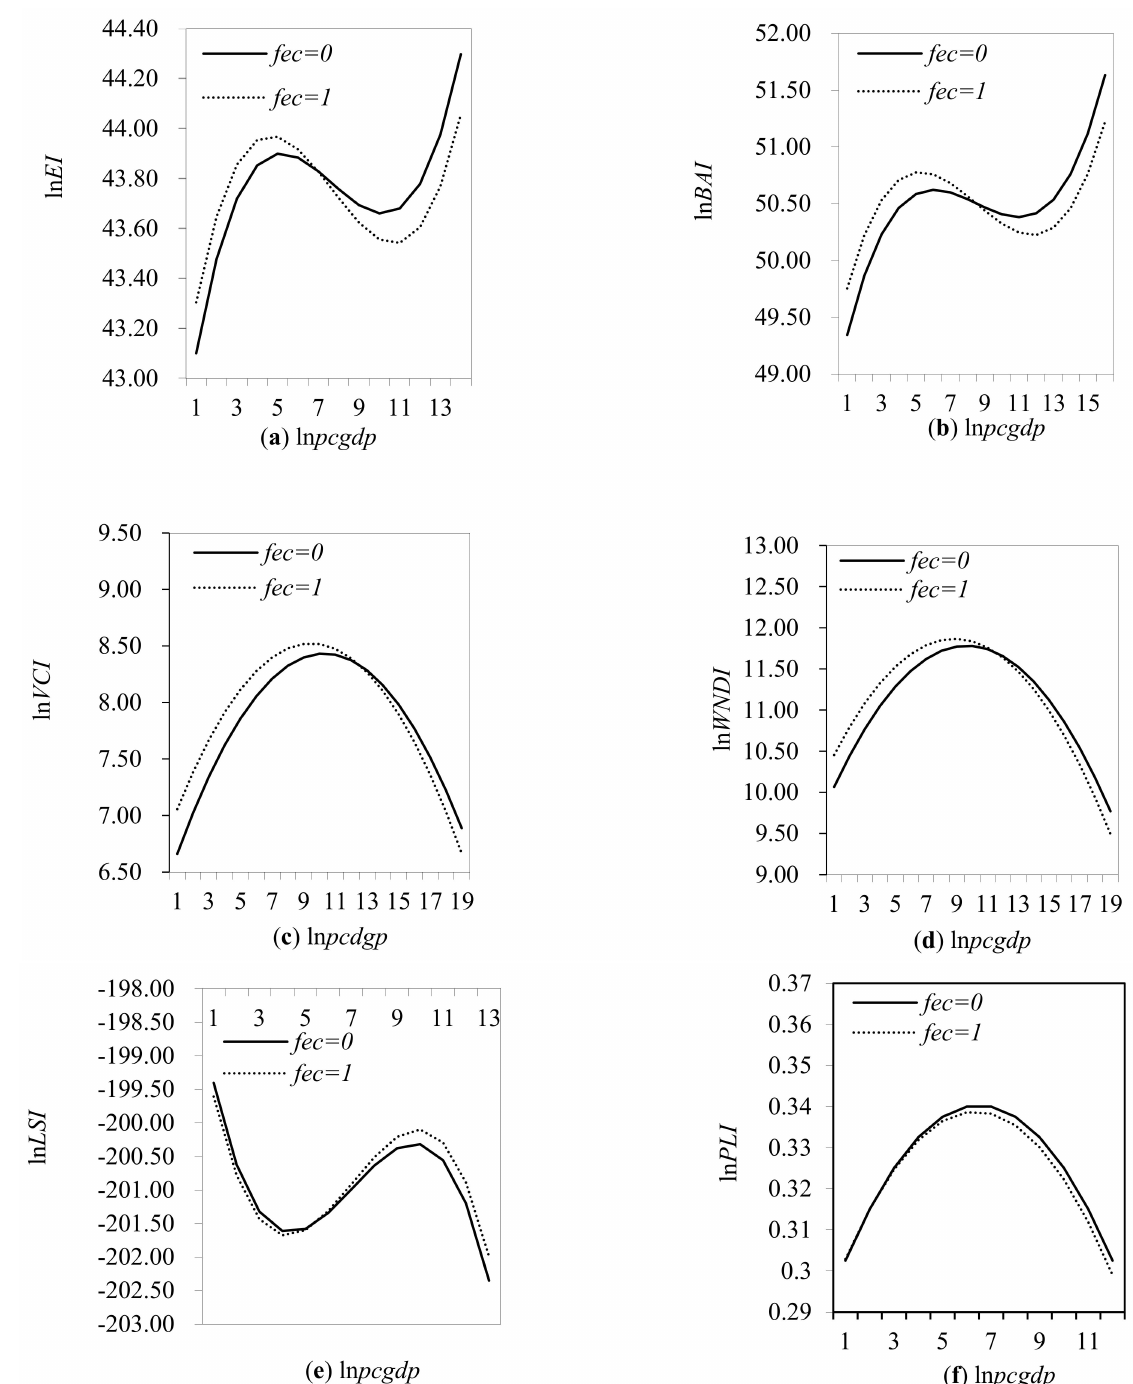
Figure 1. Impact of financial